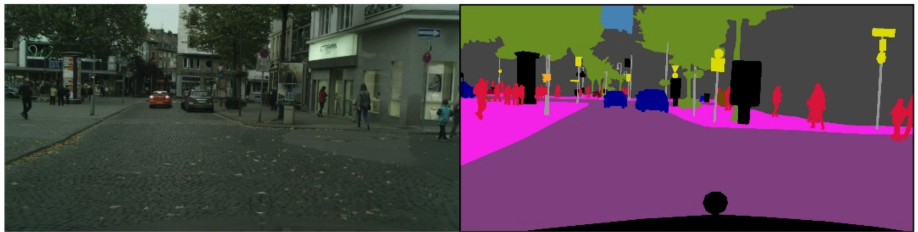
Figure 4. Test sample of Cityscape dataset ( left : original image, right : labeled